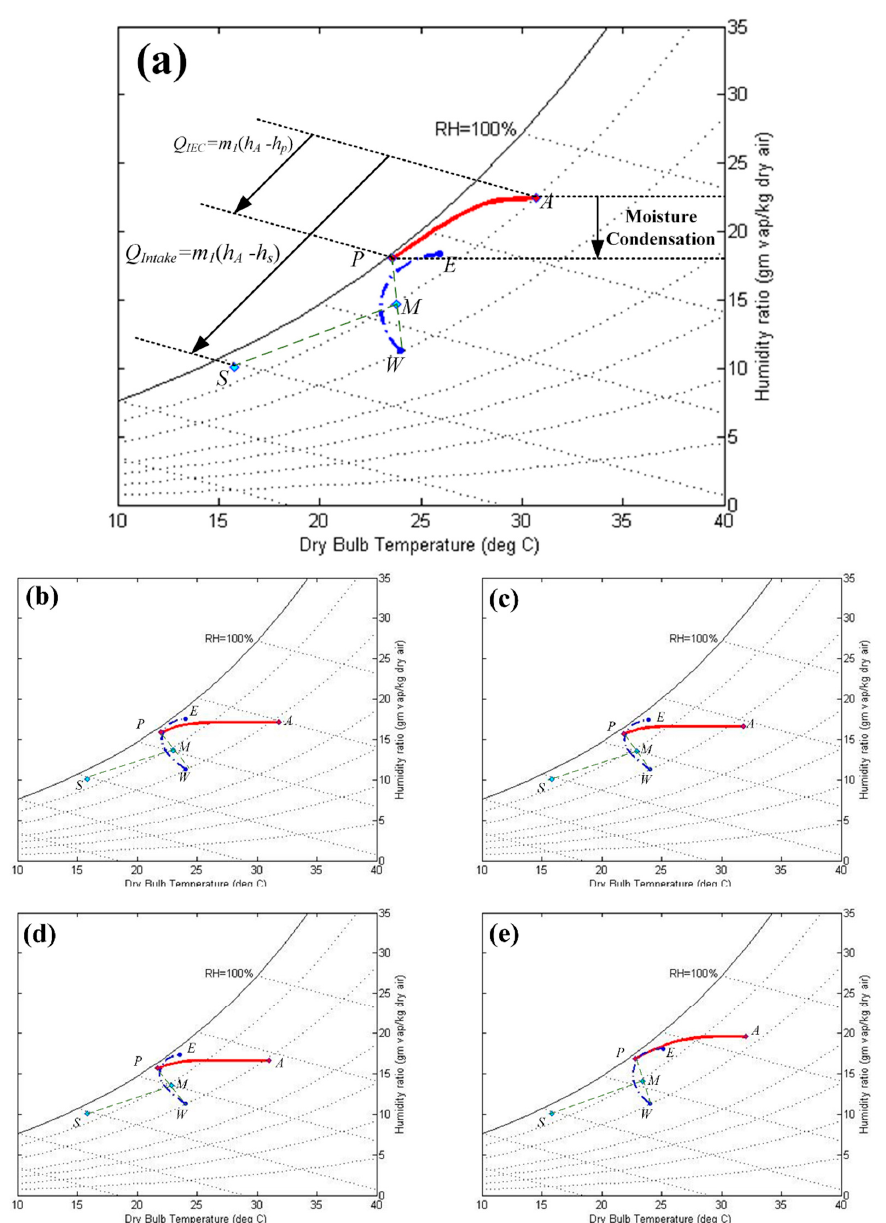
Figure 10. Description of air conditions on psychrometric chart for the hybrid system operating under the design conditions of ( a ) Singapore, ( b ) Cairo, ( c ) Firenze, ( d ) Athinai, and ( e ) Xi’an.